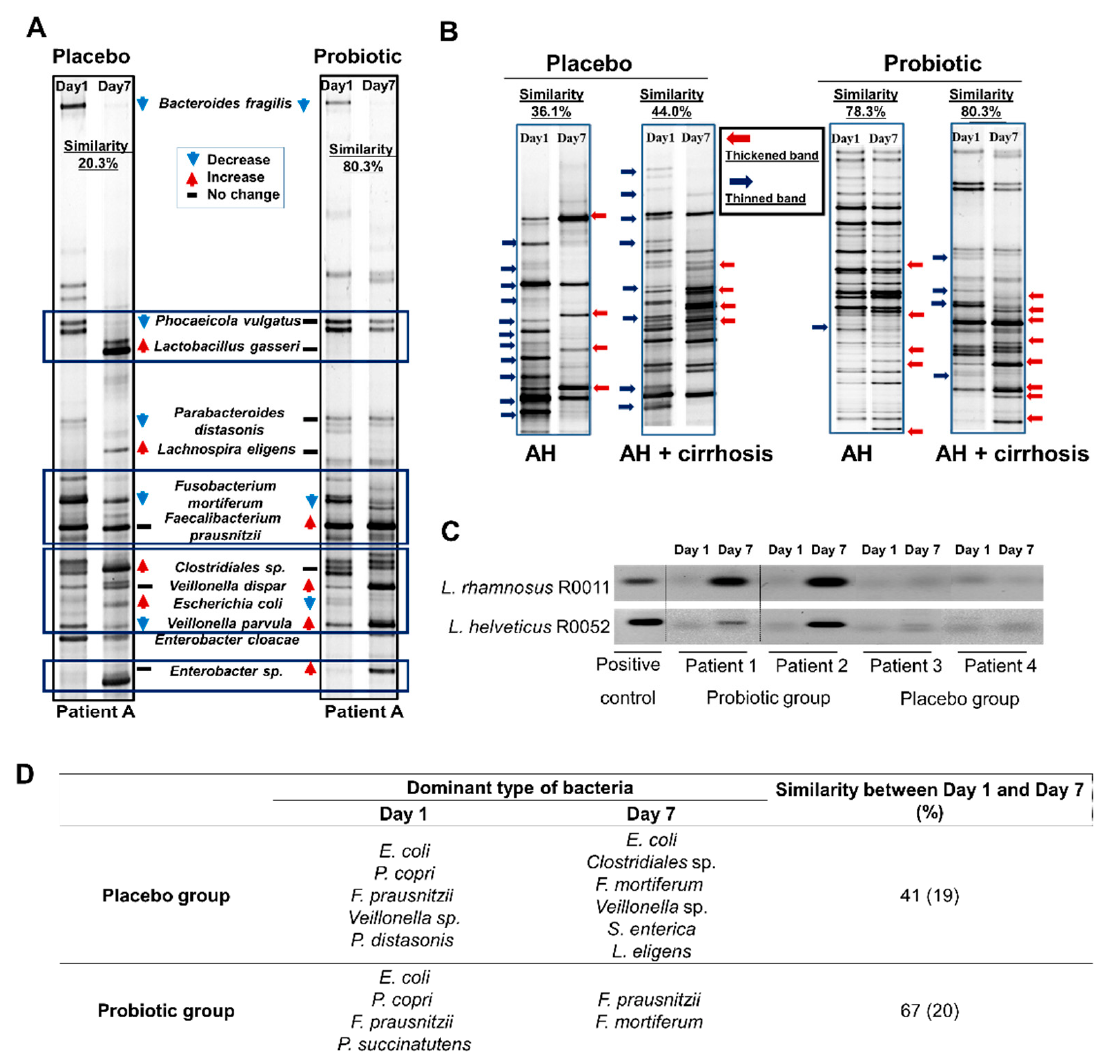
Figure 3. Dominant strains. ( A ) Electrophoresis result represents the microbial changes in patient A that was treated by both placebo (Patient 10) and probiotics (Patient 17) at different time points. ( B ) Change of diversity in both groups. Representative PCR-DGGE image used for analysis ( C ) PCR amplification for detection of Lactobacillus . ( D ) Dominant strains and similarity in placebo and probiotic group at day 0 and day 7. PCR-DGGE, polymerase chain reaction–denaturing gradient gel electrophoresis.